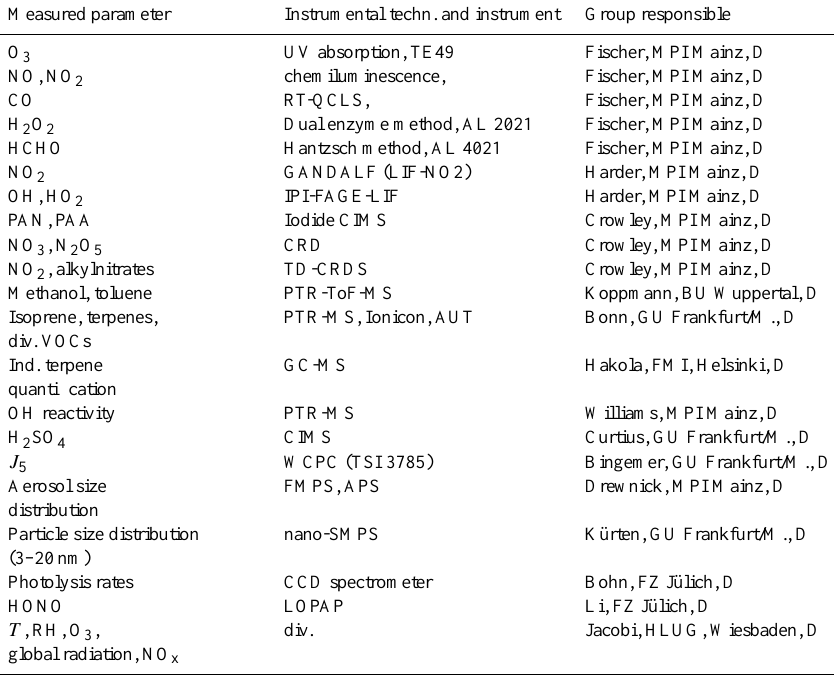
Table 1. Measured parameter, instrumentation and groups responsible during the campaign. Measured parameter